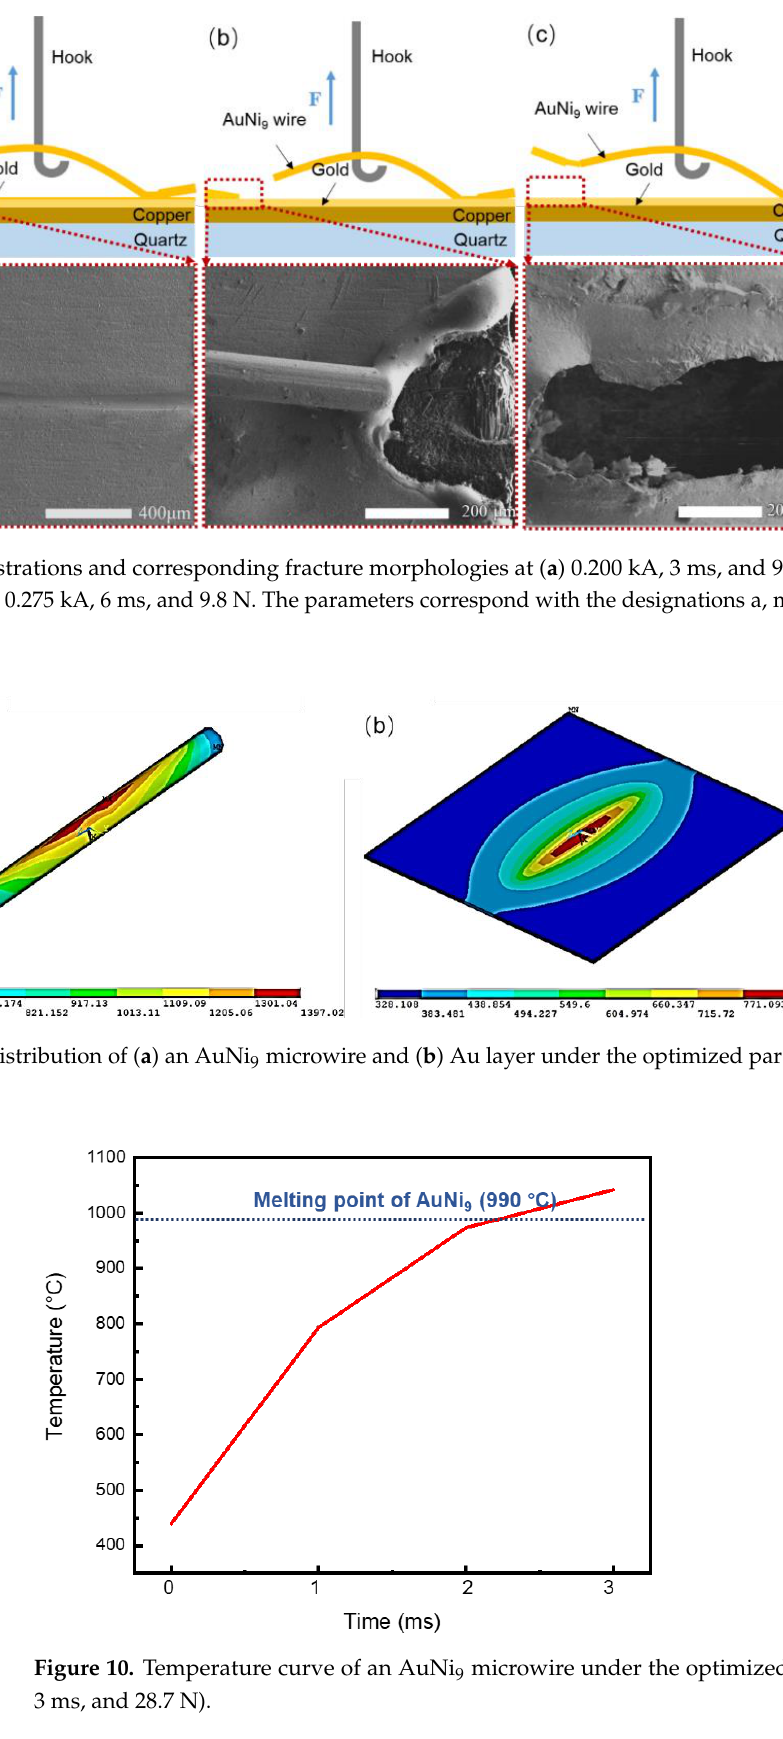
8 of 11 Figure 7. Dynamic resistance curves during the welding process at ( a ) 0.200 kA, 3 ms, and 9.8 N; ( b ) 0.275 kA, 3 ms, and 28.7 N; and ( c ) 0.275 kA, 6 ms, and 9.8 N. The inset images are the corresponding morphologies. The parameters correspond with designations a, m, and d in Table 1, respectively. Figure 8 shows the representative fracture morphologies of the welded joints under